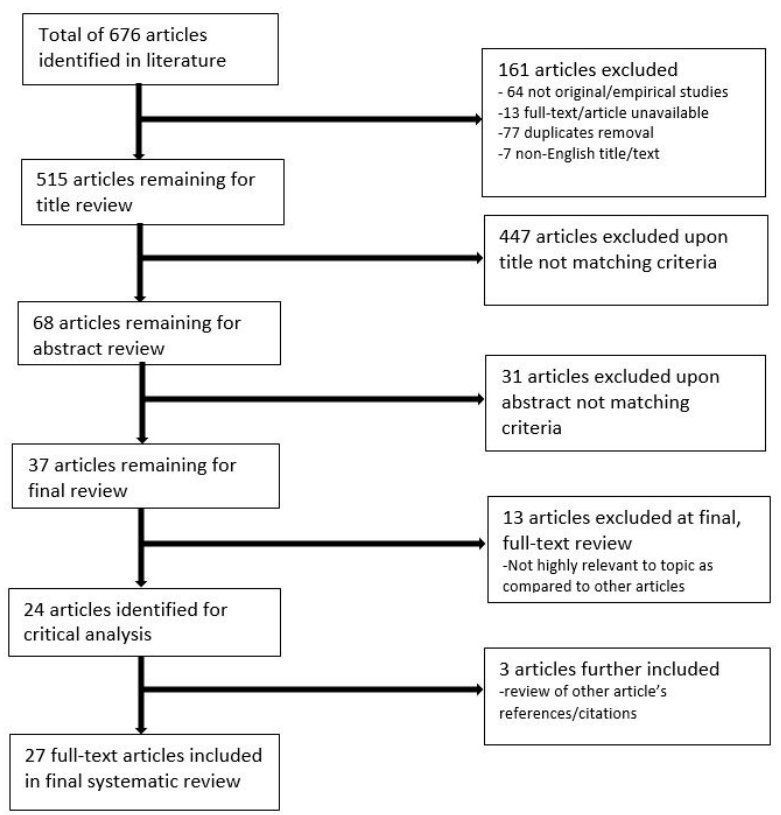
Figure 1. Flow chart demonstrating identification of relevant literature.